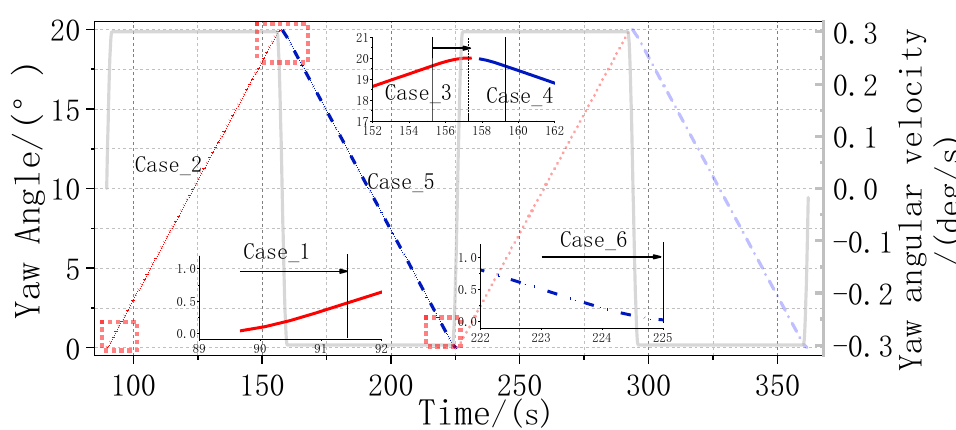
Figure 18. Six cases during the start-stop stage under dynamic yaw.